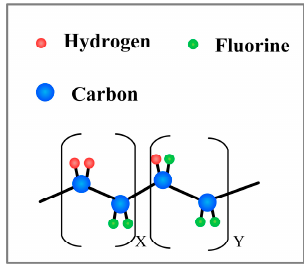
Figure 4. Schematic representation of the Poly(vinylidene fluoride trifluoroethylene) (P(VDF-TrFE)) repeat units